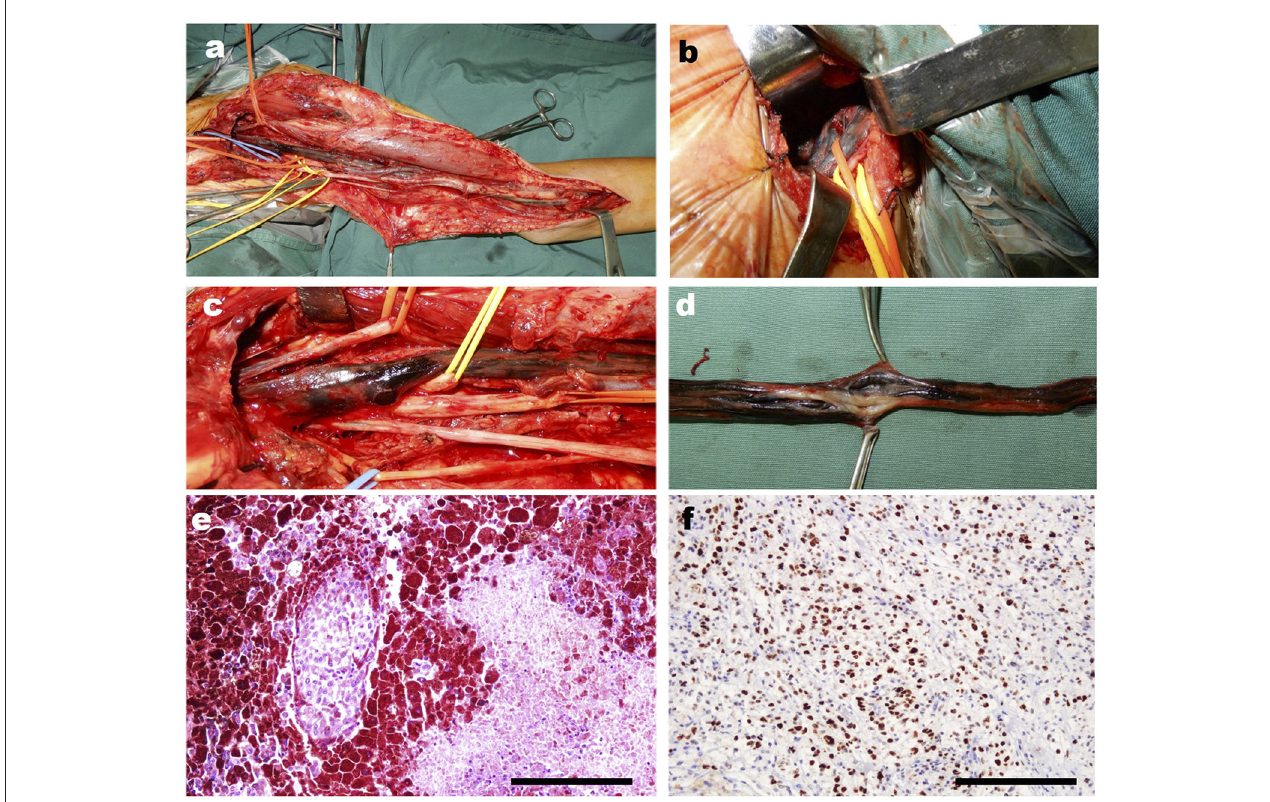
FIGURE3 The intra-operative photographs of the patient’s second operation in our hospital. (a) The overall photograph of the mass in the patient’s left arm. (b) The intraoperative photograph of the mass in trunks of the brachial plexus. (c) The close-up detail photograph of the black changed the nerves of the patient. (d) The close-up detail photograph of the black changed nerve shows the change of the never fibers intra epineurium. (e) The representative HE staining image of the resected tumor. (f) The representative Ki67 immunohistochemical staining image of the resected tumor. Scar bar, 100 µ m.